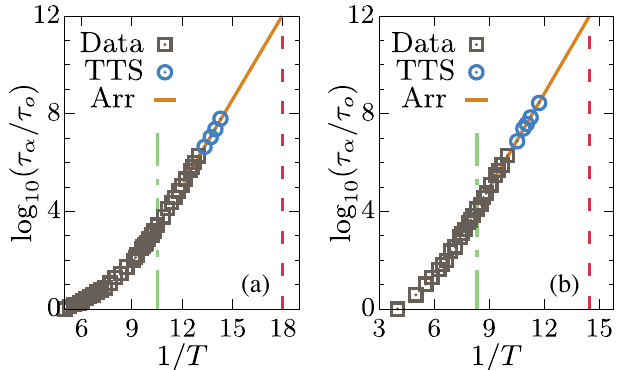
FIG. 2. Averaged relaxation times in 3D and 2D glass-forming models. Relaxation time τ α rescaled by its value τ temperature, as a function of the inverse temperature in 3D (a) and 2D (b). The data points are directly measured from Fig. 1, and extended over 1.5 decades using time-temperature superposition (TTS). An Arrhenius fit (full line) extrapolates τ α = τ 10 12 to locate the experimental glass transition temperature T (dashed line). We concentrate on the regime between T dotted line) and T g